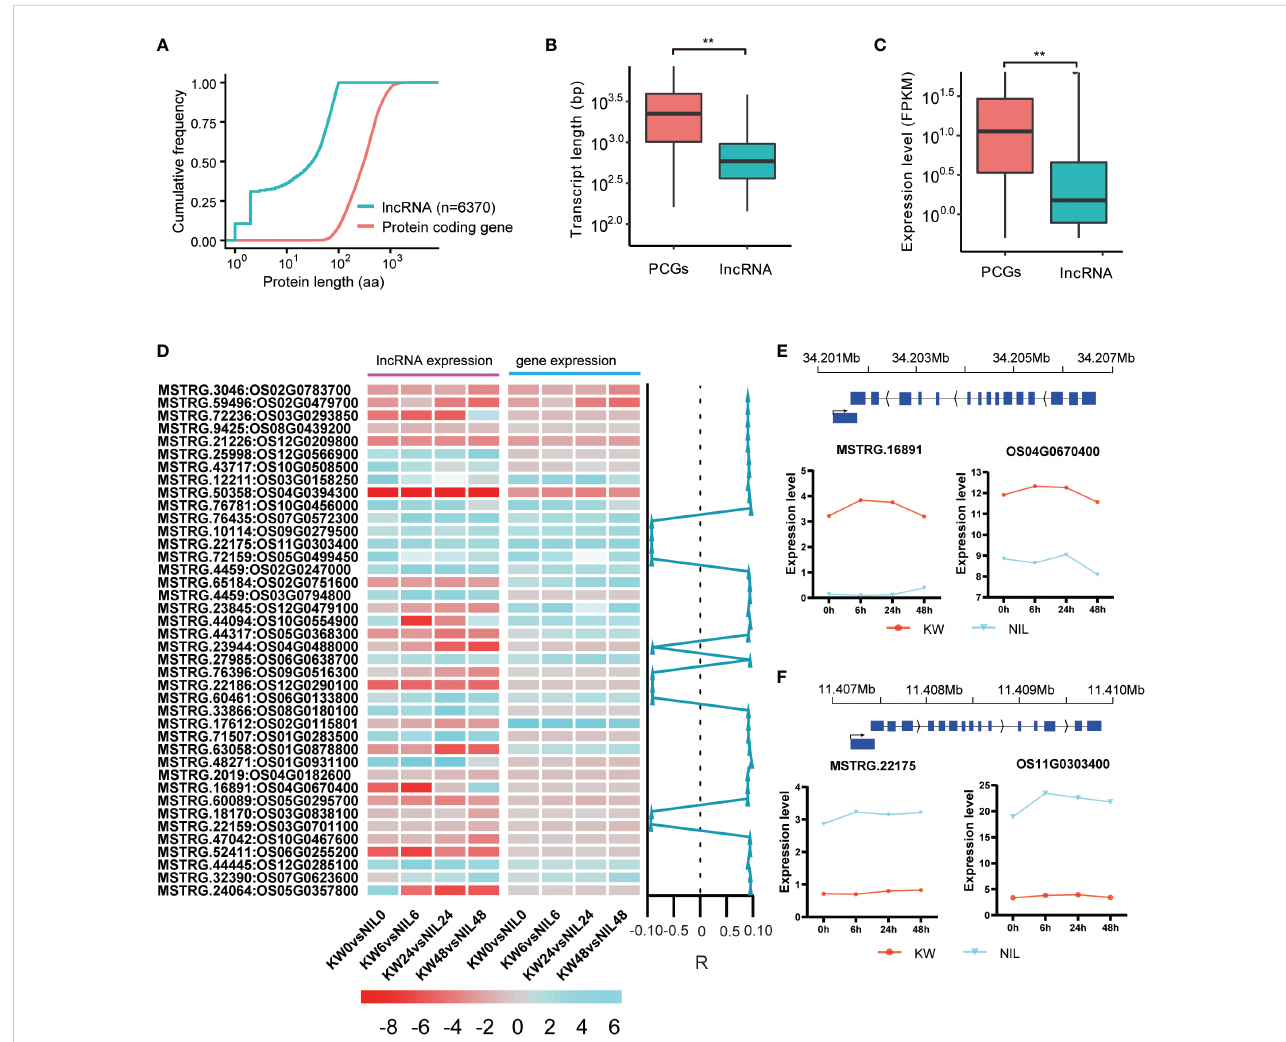
FIGURE 4 Expression pro fi les of differentially expressed long non-coding RNAs in rice exposed to BPH for KW and NIL. (A) The line graph represents the total number of predicted expressed lncRNAs and protein-coding genes (PCG). Predicted length (aa) is shown on the x-axis with scale, and cumulative frequency is revealed on the y-axis. (B) Predicted transcript lengths of the PCG and lncRNAs expressed in the study. ** represents the signi fi cant differences in transcript lengths between PCGs and lncRNAs. (C) Expression levels of the expressed PCGs and lncRNAs in the study. ** represents the signi fi cant differential expression between PCGs and lncRNAs. (D) Heat map represents the expression level of lncRNAs and their mediated genes in response to brown planthopper under KW and NIL treatments. Color scale indicates FPKM change (blue, low expression level, and red, high expression level). Correlation speci fi city score is presented on the right side of the heat map for lncRNAs and their neighboring genes. Values close to 1 mean a high correlation (R) of DELs and genes in the vicinity. (E, F) Predicted expression levels of two lncRNAs and their mediated targeted genes are speci fi ed. The y-axis represents expression levels of lncRNAs and PCG and the x-axis shows BPH treatments for KW and